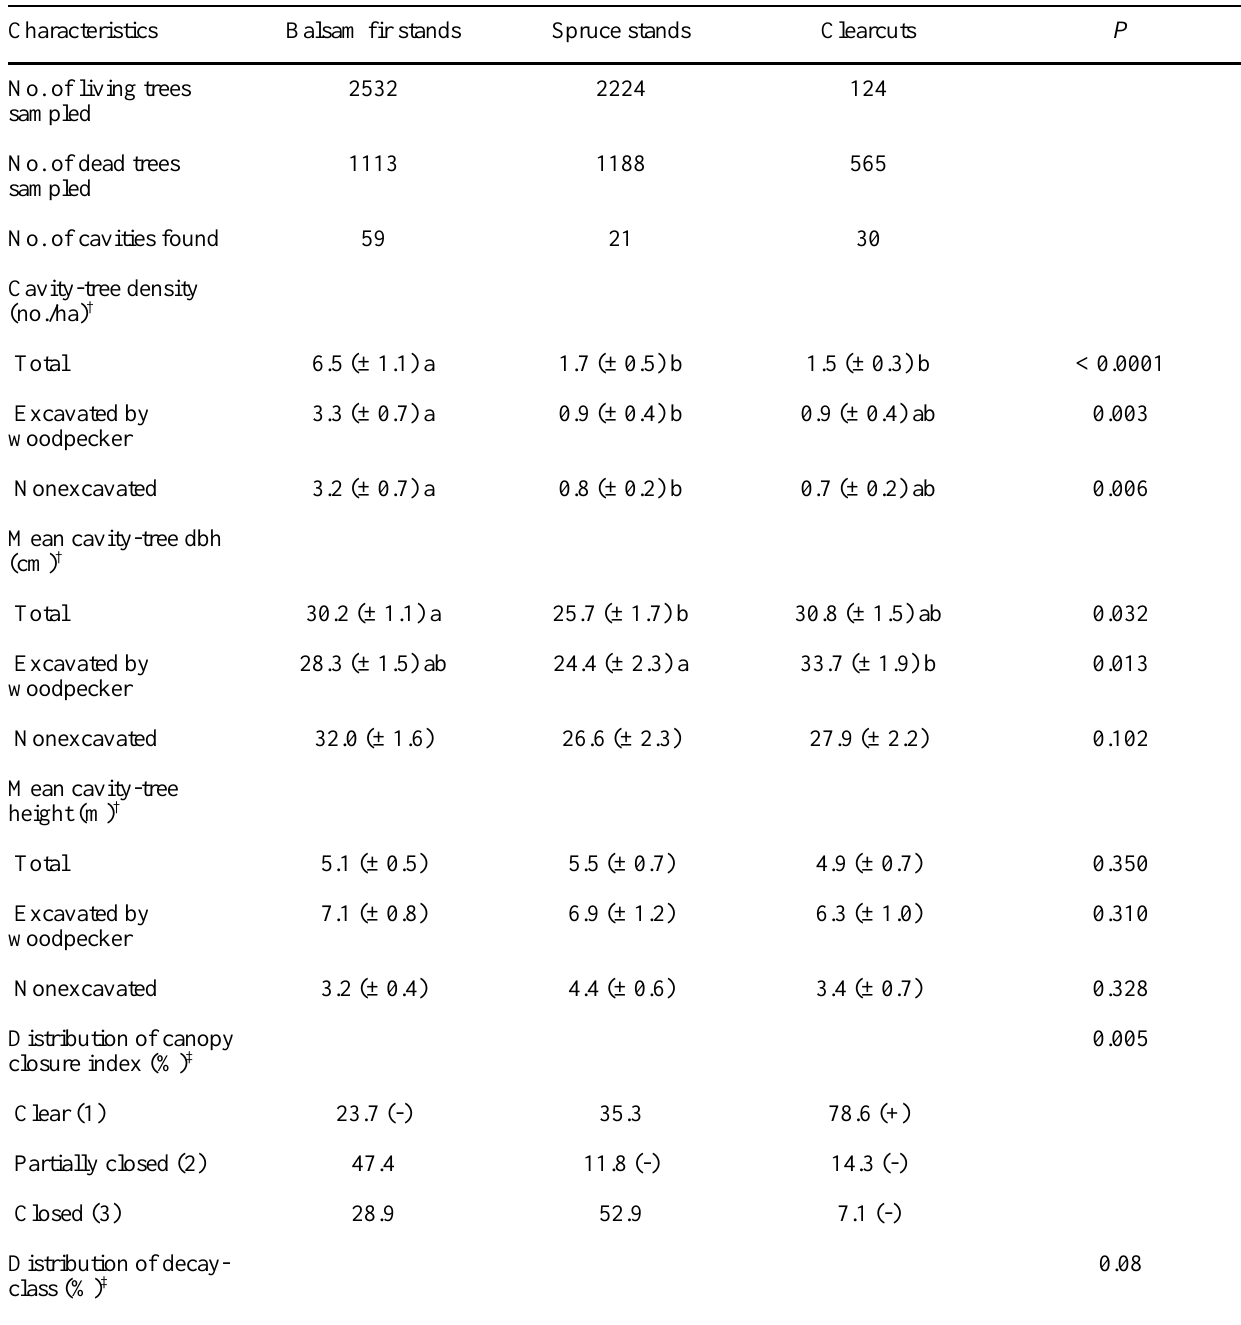
Table 1 . Characteristics of stands and trees containing cavities in balsam fir ( Abies balsamea ), spruce ( Picea sp.), and clearcut stands in the Chauvin and Martin-Valin controlled wildlife harvesting zones, Quebec, Canada, 2004–2005. The acronym “dbh” stands for diameter at breast height. “Spruce sp.” indicates snags that could be identified only with regard to genera, whereas “conifer sp.” indicates snags that could not be identified at